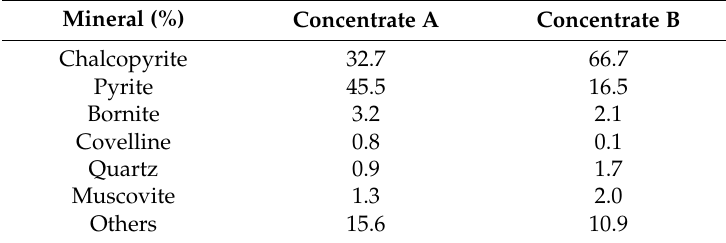
Table 3. Mineralogical composition of copper concentrate measured with a QEMSCAN ® .